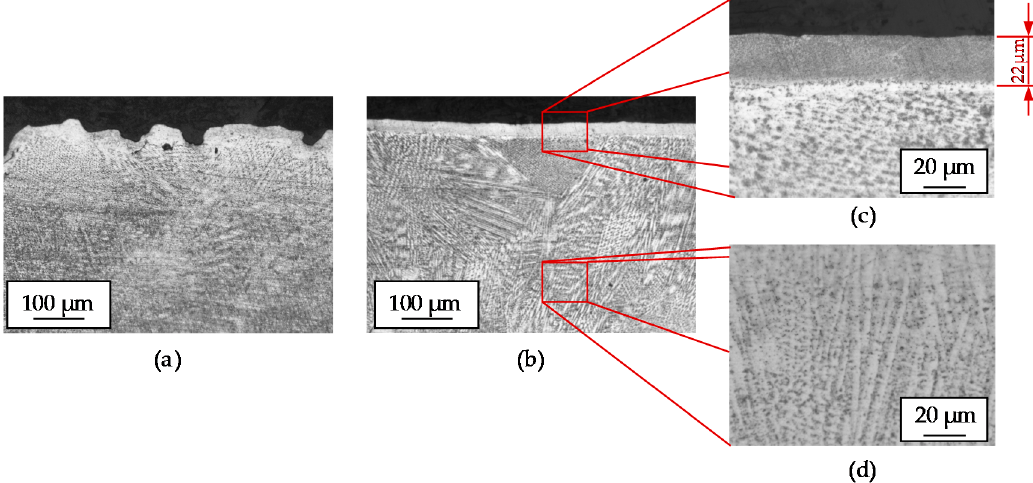
Figure 12. ( a ) Cross section of the LBM manufactured surface; ( b ) Cross section of the LBM + LP manufactured surface; ( c ) Detail of the recast layer generated on the surface due to polishing; ( d ) Internal microstructure developed as a result of the LMD process.